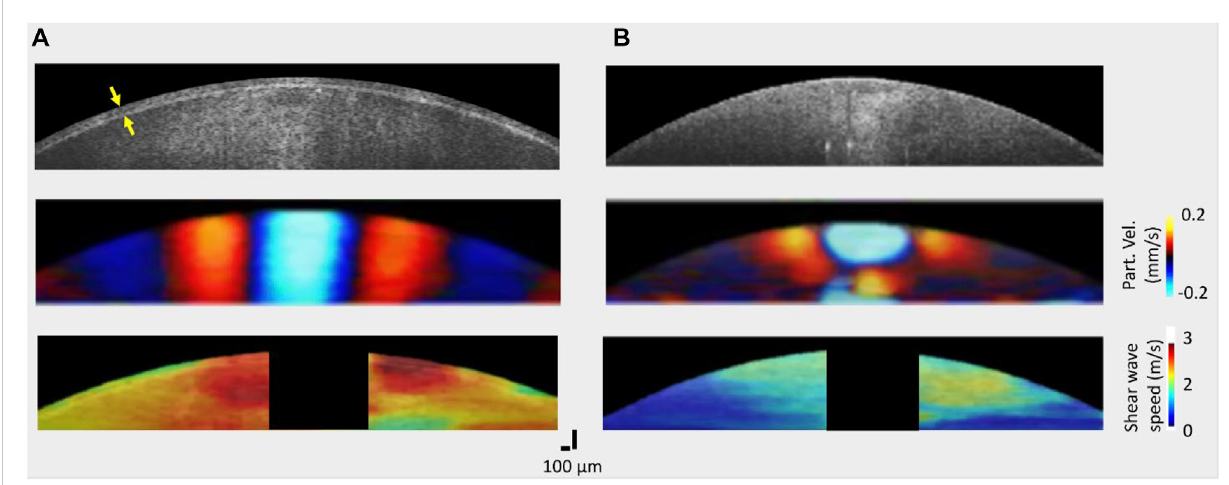
FIGURE 2 OCT structural imagesand elastic wave propagation characteristics of atypical porcine lens (A) with the capsule intact and (B) after thecapsule was removed. Top: OCT structural images acquired before (left) and after removal (right) of the capsule; middle: wave propagation snapshots indicating instantaneousparticlevelocityinanencapsulated(left)anddecapsulated(right)lens;bottom:spatialshearwavespeedmapintheencapsulated(left)and decapsulated (right) lens. The capsule layer is indicated by the yellow arrow in the top left structural image. For all samples, the excitation location was roughly at the